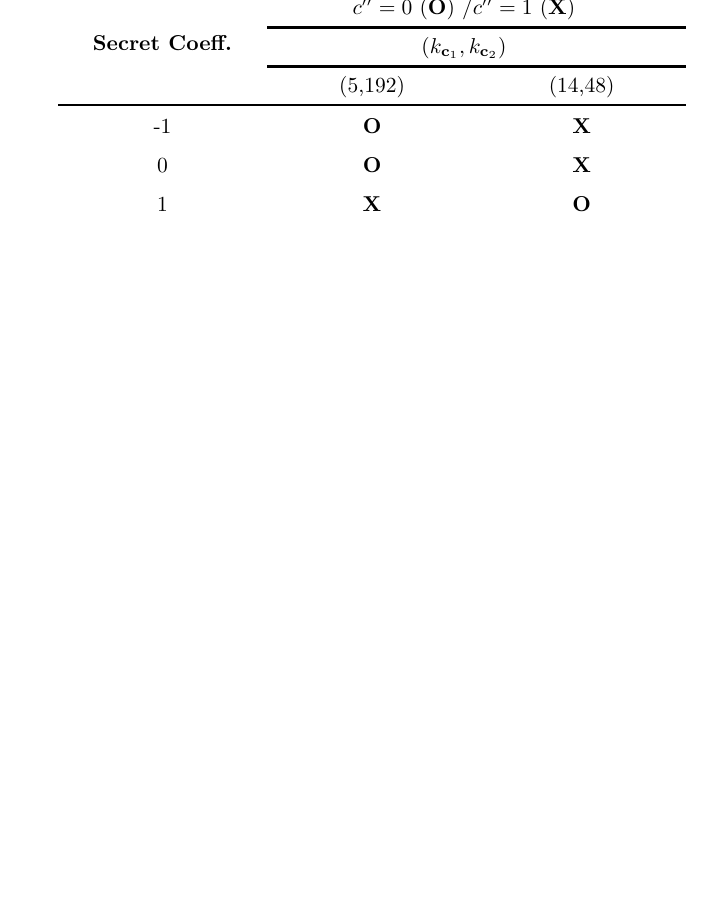
Table 2: Validity of the codeword as a function of the chosen values for the ordered pair ( k c ) and the targeted secret coefficient, used for our attack on the LAC128 variant of , k c 1 2 LAC CCA-secure KEM. O and X refer to valid ( c 00 = 0) and invalid codewords ( c 00 = 1) respectively. Secret